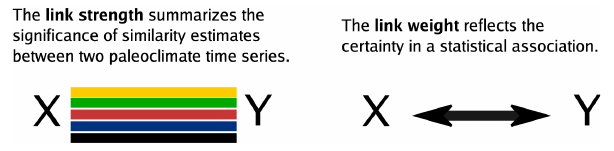
Fig. 7. The link strength concept: for each similarity estimator, sig- nificant results result in a link between the time series. The sum of these links determine the strength, or weight, of the